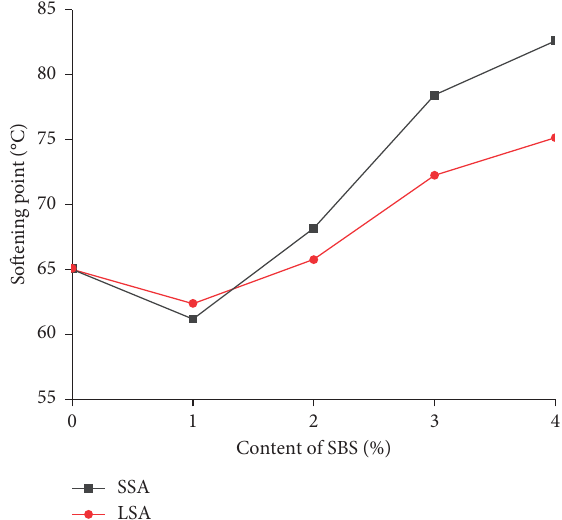
Figure 5: Variation of softening point with the SBS contents for modified